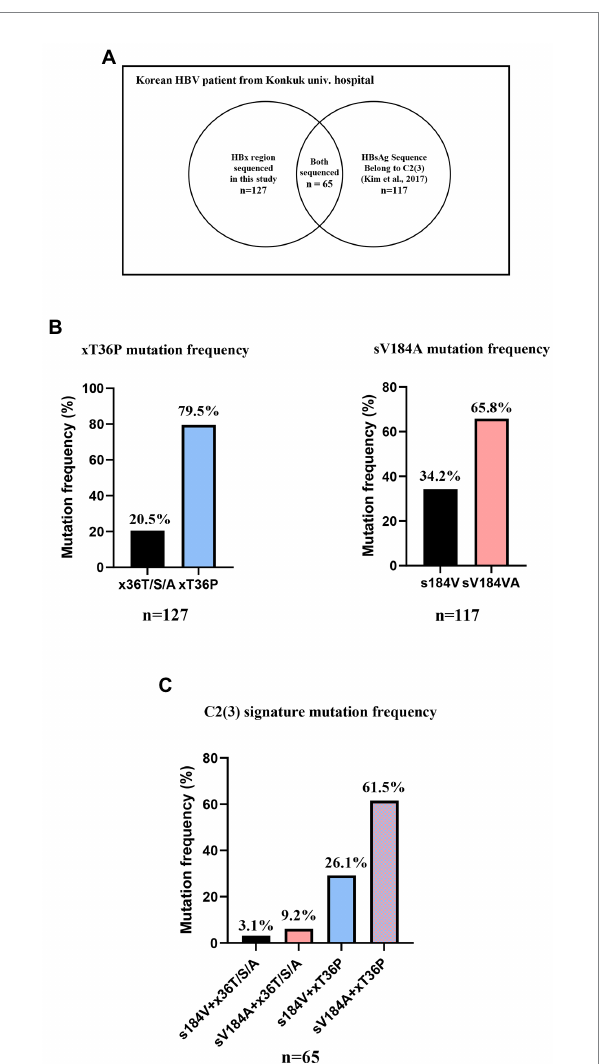
FIGURE 3 A phylogenetic tree of hepatitis B virus genotype C based on 243 genome sequences constructed using MrBayes. For phylogenetic analysis between three clades within subgenotype C2, 40 of 260 sequences from C2(1), 34 of 271 from C2(2) and 36 of 152 from C2(3) were selected. (A) Three clades of subgenotype C2 are shown in blue [C2(1)], green [C2(2)], and red [C2(3)]. (B) Comparison of HBV genetic diversity among clades C2(1), C2(2), and C2(3). * p < 0.05;